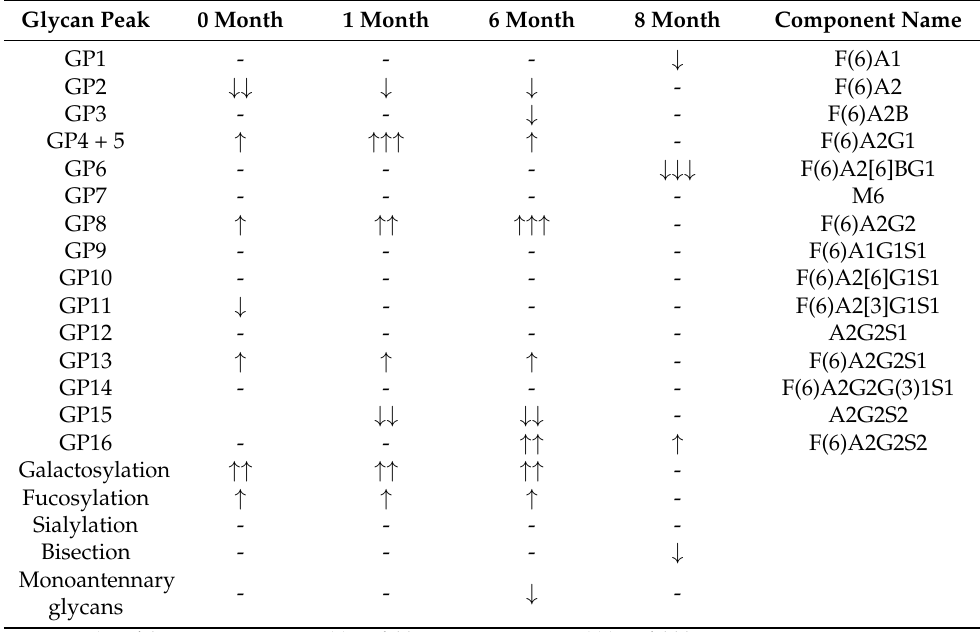
Table 1. The change trend of serum IgG glycan group H in male mice compared with group C at different time points in the process of cancer